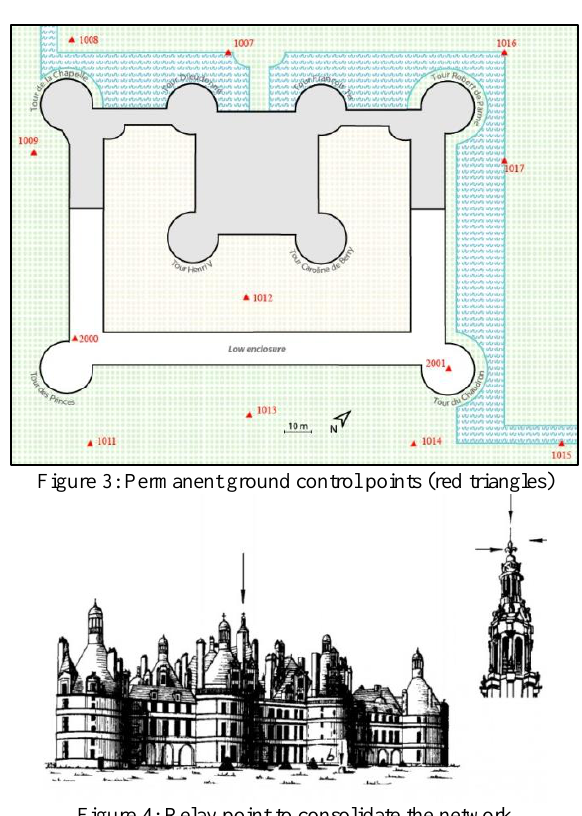
Figure 4: Relay point to consolidate the